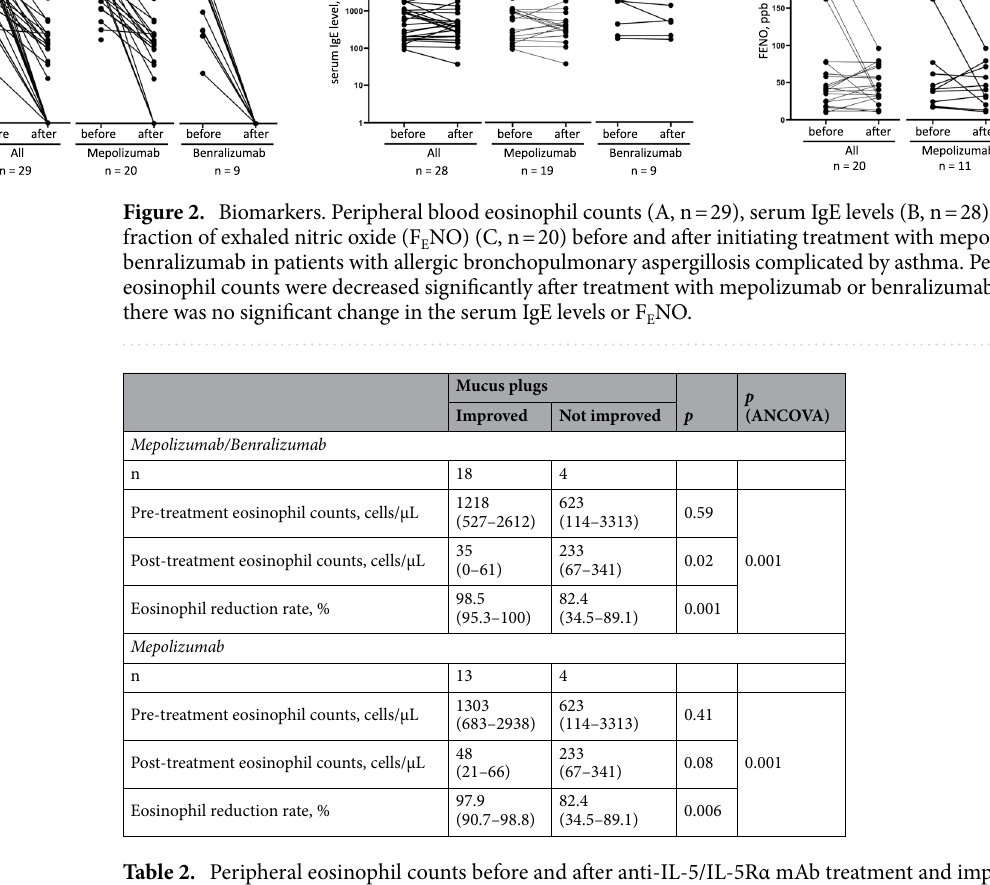
Table 2. Peripheral eosinophil counts before and after anti-IL-5/IL-5Rα mAb treatment and improvement of mucus plugs. Values are represented as the median (interquartile range). AVCOVA analysis of covariance.